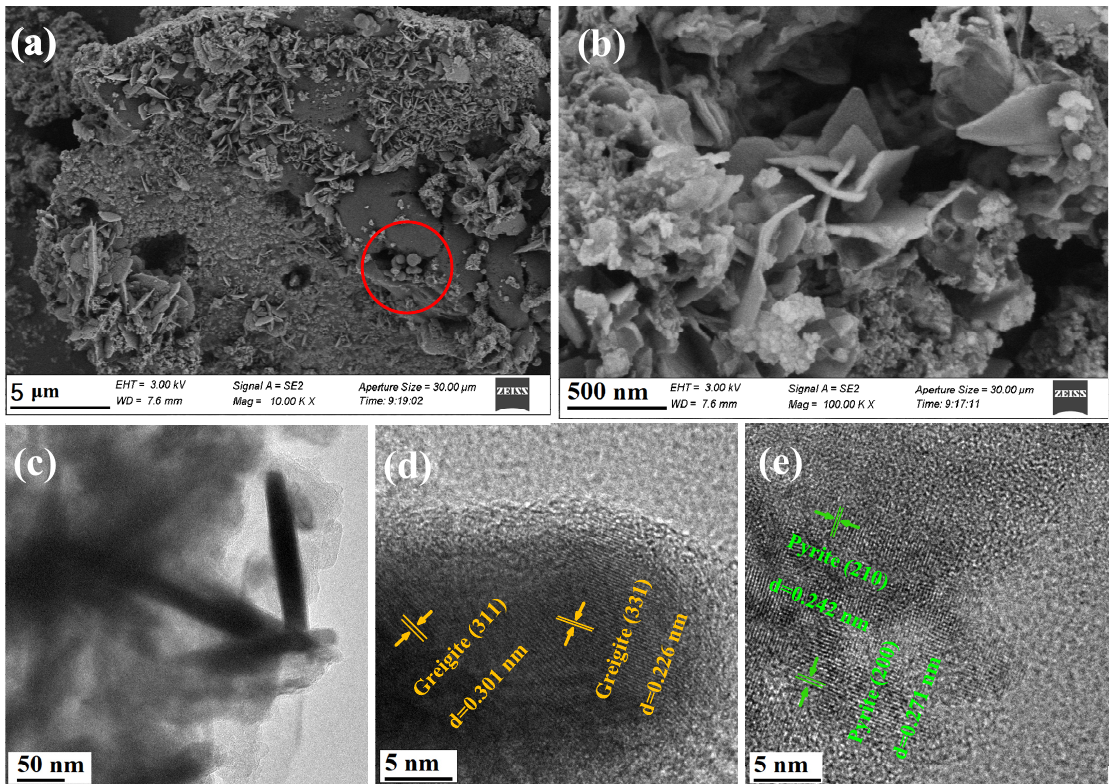
Figure 2. ( a , b ) SEM images of CS-Fe-2 at different magnification; ( c ) TEM images of CS-Fe-2; ( d , e ) HRTEM images of CS-Fe-2 at different positions.